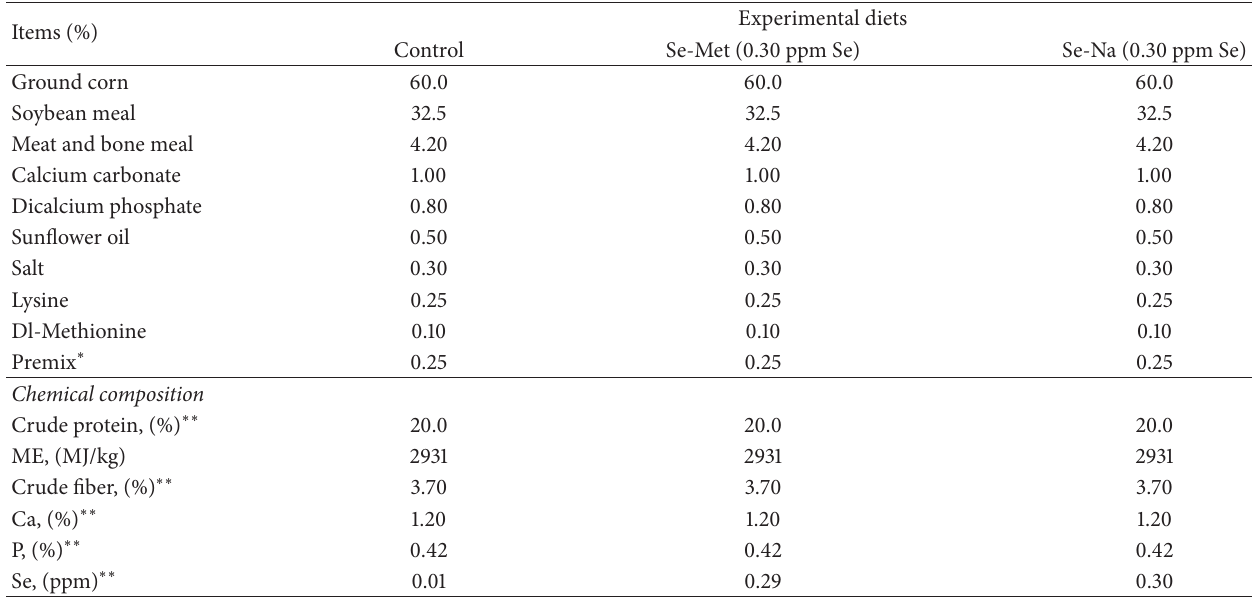
Table 1: Chemical composition of experimental